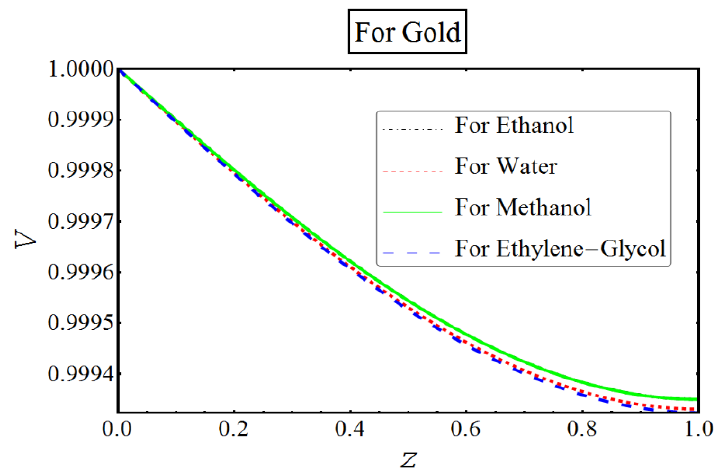
Figure 14. Behavior of azimuthal velocity for each fluid with gold particles.